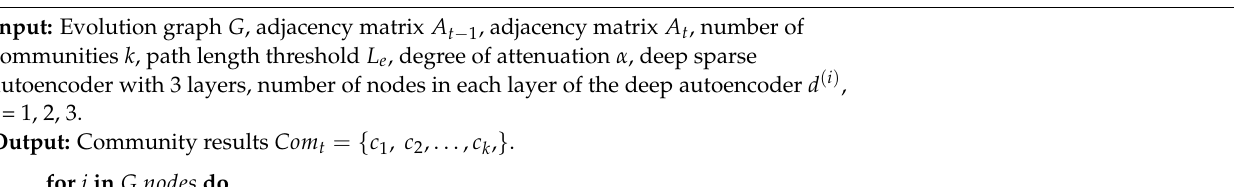
Algorithm 1. LCDEN